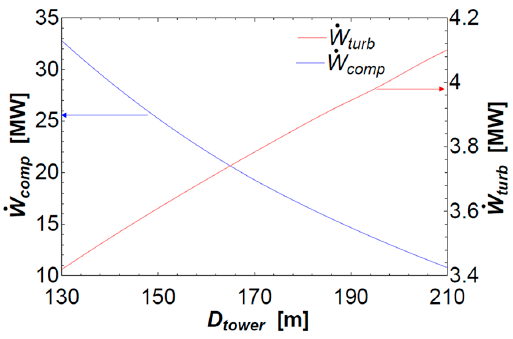
Figure 9. Compression work and turbine power output change with tower diameter.